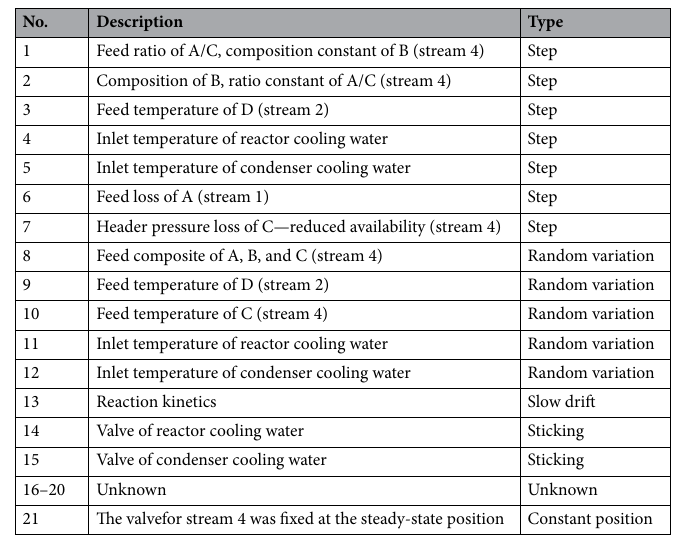
Table 3. Descriptions of faults in the Tennessee Eastman process 33 .